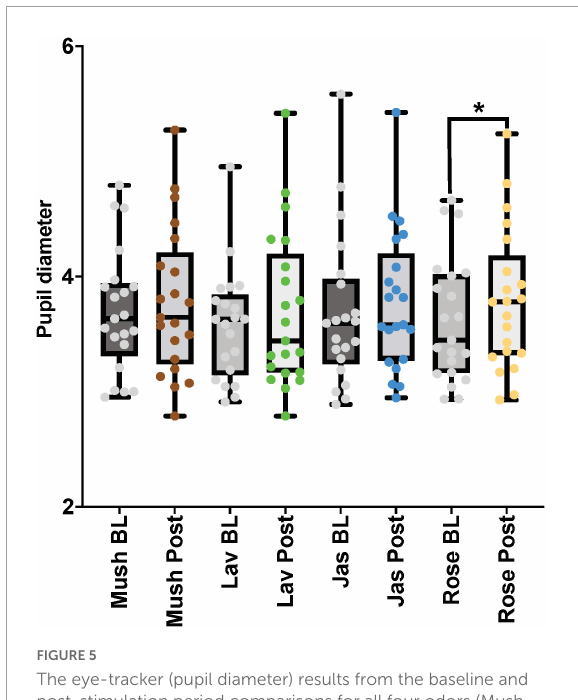
FIGURE5 The eye-tracker (pupil diameter) results from the baseline and post-stimulation period comparisons for all four odors (Mush, mushroom; Lav, lavender; Jas, jasmine; Rose, rose) in all four concentrations (sham stimulation, low, moderate, and high) for the male cohort. * p -value < 0.05 from the paired tests